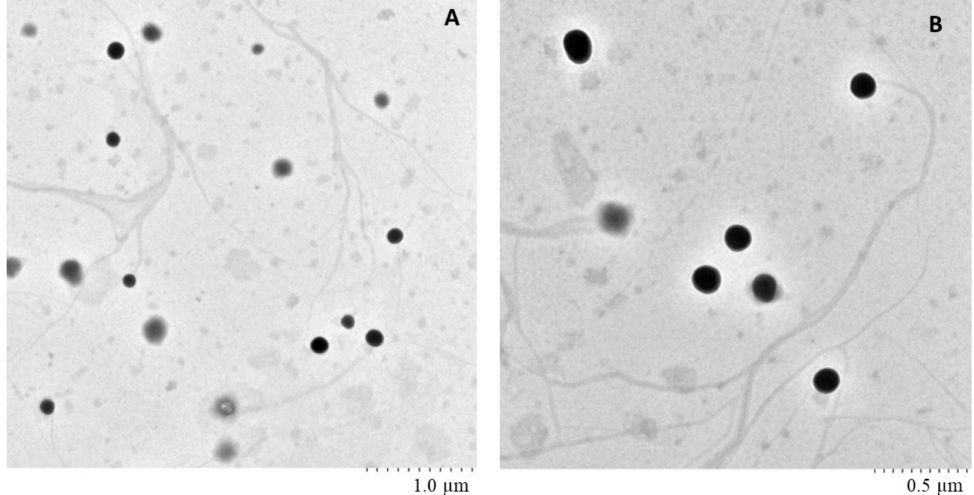
Figure 3. TEM images of nanoemulsion at different magnification ( A ) scale 1.0 µ m, ( B ) scale 0.5 µ